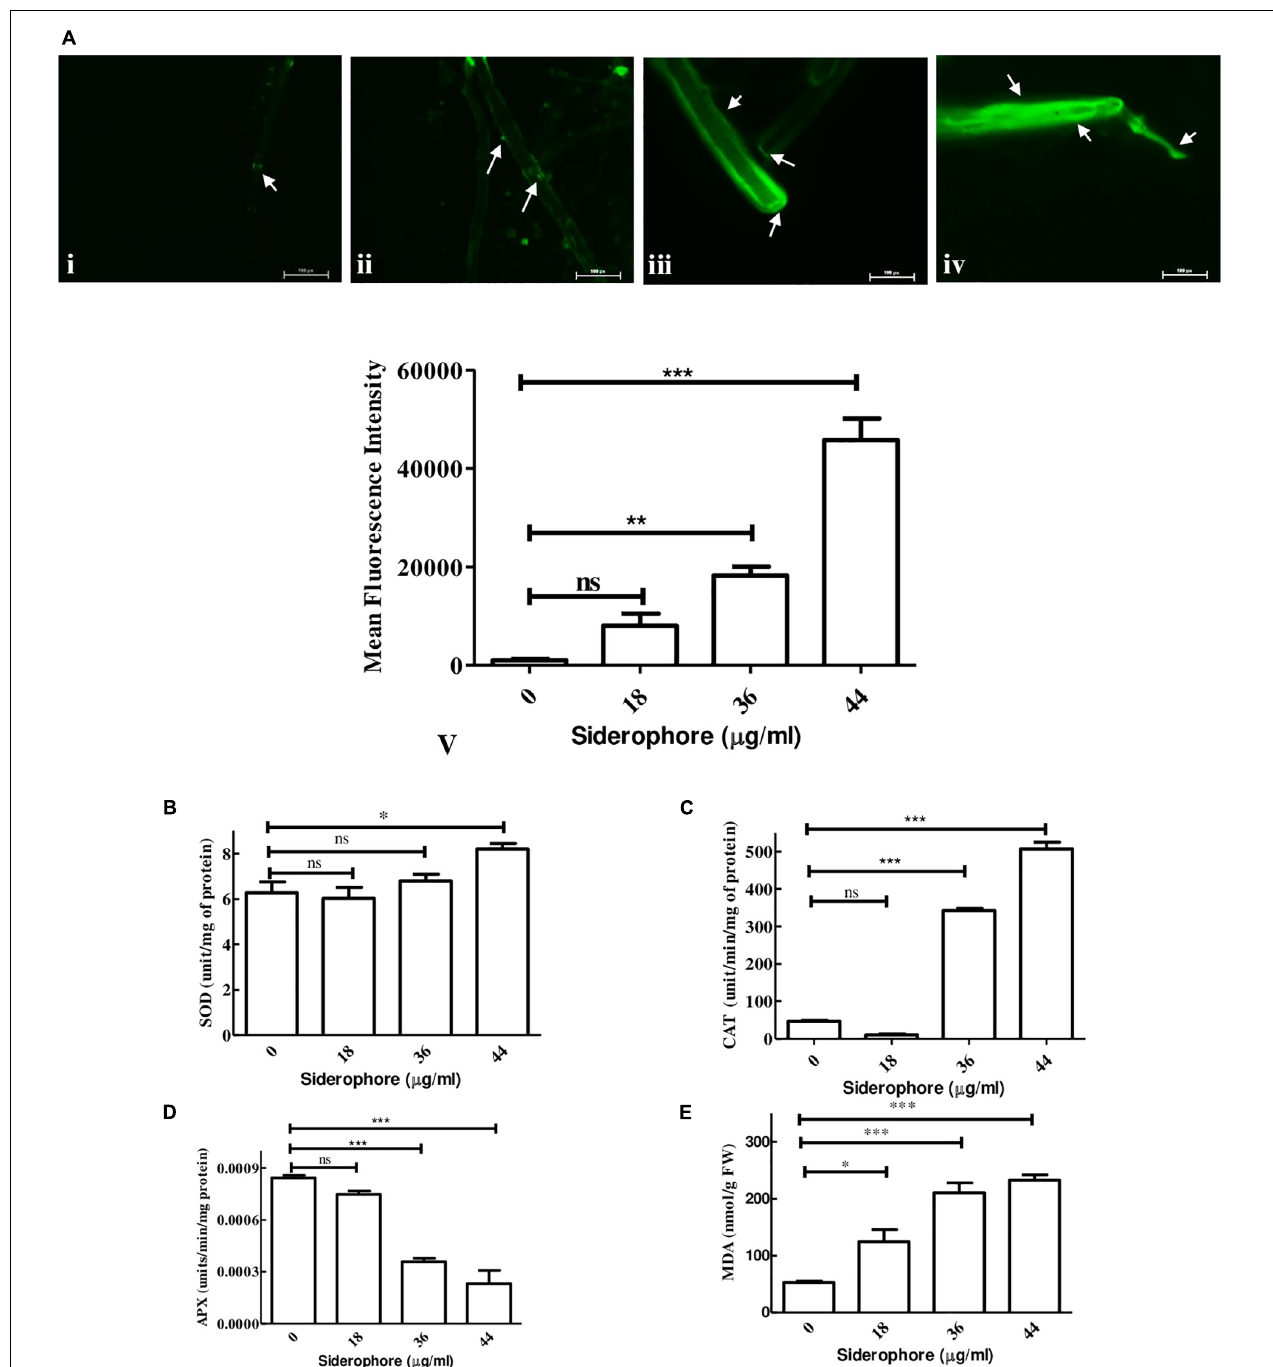
FIGURE 6 | Effect of varying concentrations of catecholate siderophore on (A) ROS accumulation visualized by DCFDA staining (arrows indicate representative sites of ROS accumulation): i—control; ii—18 µ g/ml; iii—36 µ g/ml; iv—44 µ g/ml; v—mean fluorescent intensities from DCFDA staining. (B) Superoxide dismutase activity. (C) Catalase activity. (D) Ascorbate peroxidase activity. (E) MDA content in A. nidulans (ns—non-significant, ∗∗∗ p ≤ 0.001—highly significant, ∗∗ p ≤ 0.01—very significant, and ∗ p ≤